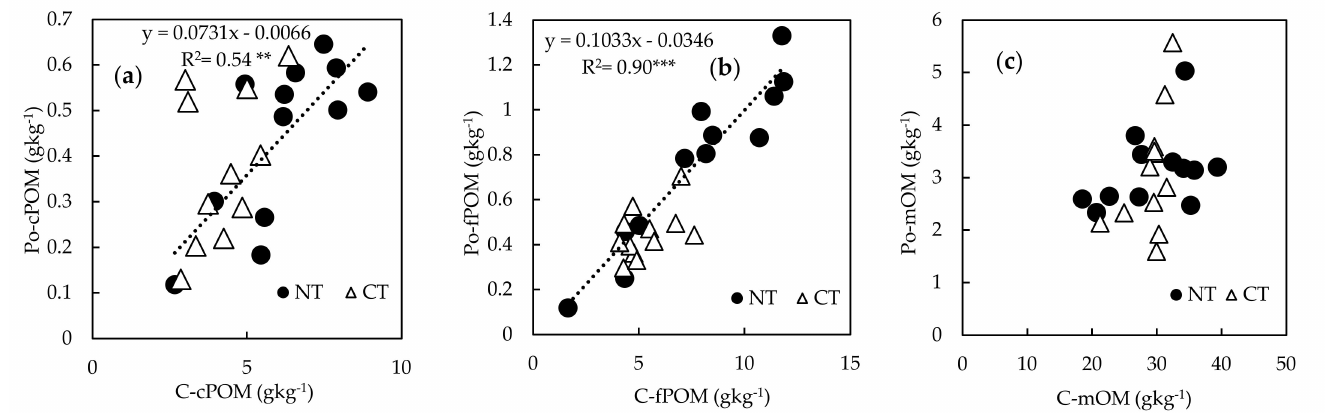
Figure 6. Relationship between organic P (Po) and total carbon (C) content of the various SOM fractions by physical fractionation of Andosols from no-tillage (NT) ( a , b ) and conventional tillage (CT) system-cultivated land under ryegrass (RY) at various depths ( c ). * p < 0.05, ** p < 0.01, and *** p < 0.001 using program regression and ANOVA. The continuous line ( — ) represents the regression line for